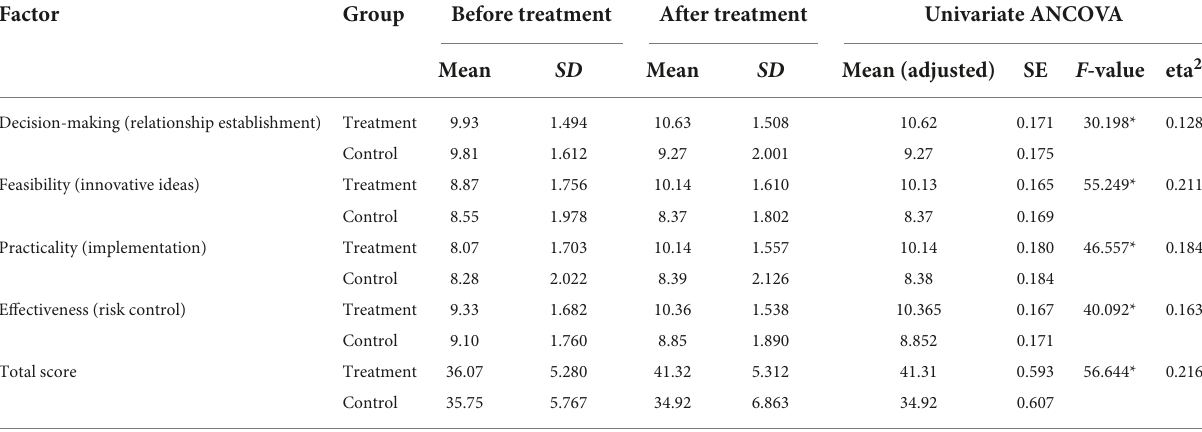
TABLE 5 Descriptive statistics of students’ pretest and posttest scores and ANCOVA summary of innovative thinking. Factor Group Before treatment After treatment Univariate ANCOVA Mean SD Mean SD Mean (adjusted) SE F- value eta